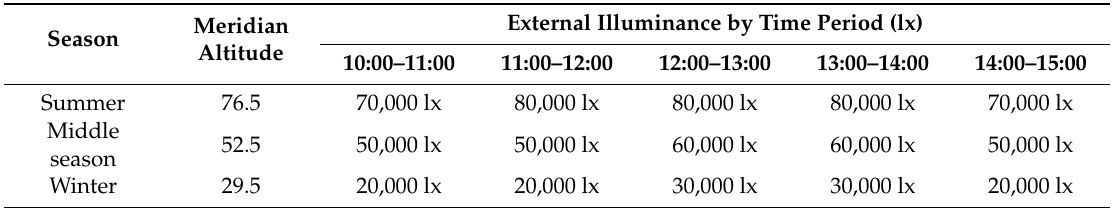
Figure 9. Light distribution and conical illuminance of lighting. Table 5. Solar altitude and external illuminance by time period for summer, mid-season, and winter.